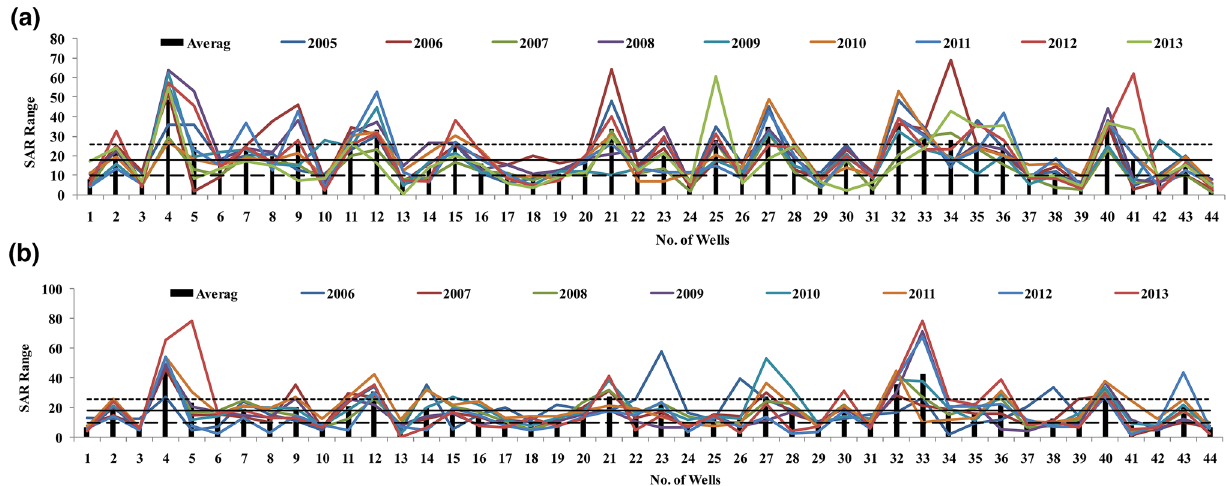
Fig. 2 a Nine-year (2005–2013) temporal representation of SAR value during pre-monsoon. b Nine-year (2006–2013) temporal representation of SAR value during